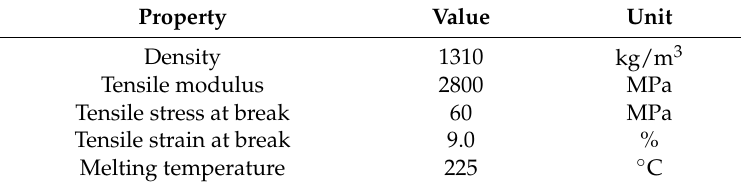
Table 3. Material properties of the investigated PBT matrix material “Pocan ® B 1305/Lanxess” [30].